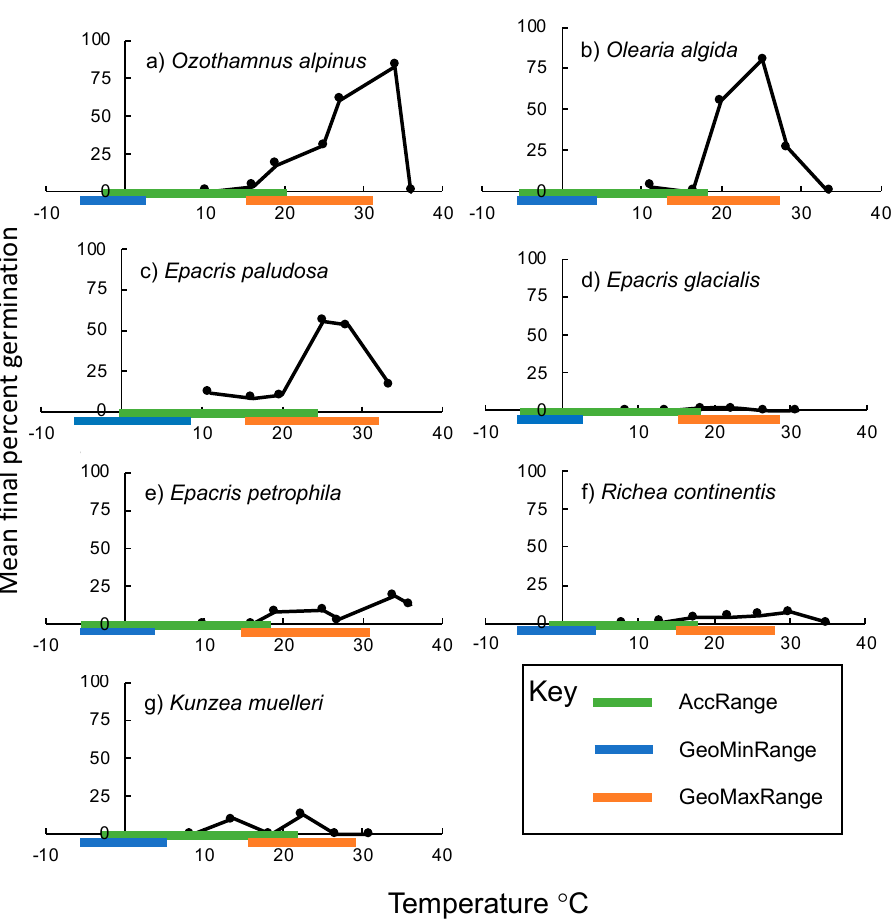
Figure 1. The germination niche as described by the mean final percent germination across a gradient of temperatures for the seven study species ( a ) Ozothamnus alpinus, ( b ) Olearia algida , ( c ) Epacris paludosa , ( d ) Epacris glacialis , ( e ) Epacris petrophila, ( f ) Richea continentis , ( g ) Kunzea muelleri . Temperature metrics for each seed accession site and species geographic range, as extracted from gridded average historic climate datasets (1990–2009), are indicated by colored lines: Green lines (AccRange) indicate the seed accession temperature range, the minimum temperature in the coldest month to the maximum temperature the warmest month at the accession site; blue lines (GeoMinRange) indicate the lowest and highest minimum temperatures of the coldest month across the entire species geographic distribution; and orange lines (GeoMaxRange) indicate the lowest and highest maximum temperatures of the warmest month across the entire species geographic distribution.